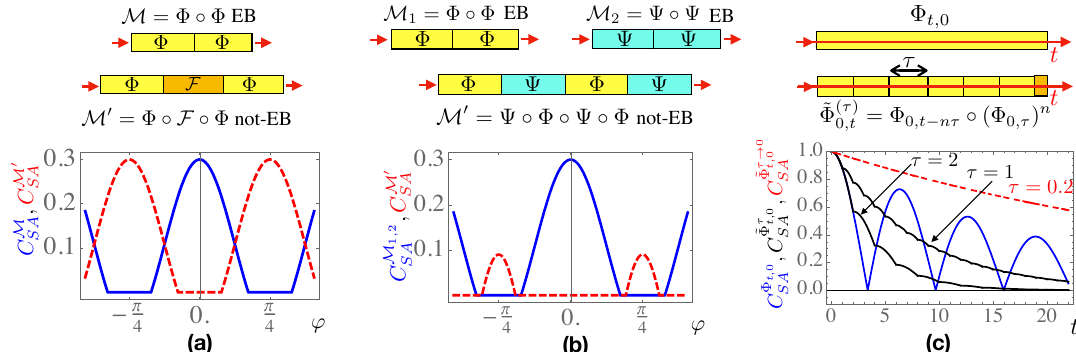
Figure 2. Techniques for recovering the transmission of quantum correlations in presence of an EB dynamics. The curves refer to concurrence values of Choi-Jamiołkowski state for the indicated maps. Φ with Φ = = Φ ( a ) The blue solid line corresponding to , shows that is EB M ◦ A η = 0.3 ◦ U ϕ M = π /4, which can be “corrected” thanks to a filter around ϕ = as showed by the red ± F U π /4 dashed curve. ( b ) The blue solid line represents the value of concurrence yielding the same value Φ and Ψ with Φ = = Φ = Ψ for the channels and Ψ = . Two M 1 ◦ M 2 ◦ A η = 0.3 ◦ U ϕ U ϕ ◦ A η = 0.3 π /4. The red dashed map, referring to the composite map EB-regions emerge, located around ± Φ Ψ Φ = ( = Ψ ) ( ) ( ) ( ) , shows that M (cid:48) ◦ ◦ ◦ A η = 0.3 ◦ U ϕ ◦ A η = 0.3 ◦ U π /4 ◦ A η = 0.3 ◦ U ϕ ◦ A η = 0.3 ◦ U π /4 in such regions correlations can be transmitted again. ( c ) Concurrence values of the Choi-Jamiołkowski state of a non-Markovian evolution for a quibt S interacting with a bosonic bath with spectral density α (cid:96) 2 J ( ω ) = 1 with α 0 the effective coupling constant, (cid:96) the width of the Lorentzian 2 π ( ω 0 ≥ ω ) 2 + (cid:96) 2 − spectrum, and the frequency ω 0 gauging the energy gap of S . Here we have set α = 5 ω 0 t and (cid:96) = 0.1 ω 0 . The blue solid line refers to the associated map Φ t ,0 , while the solid black lines and the red dashed one refer to the perturbed mapping ˜ Φ ( τ ) for smaller and smaller values of τ t